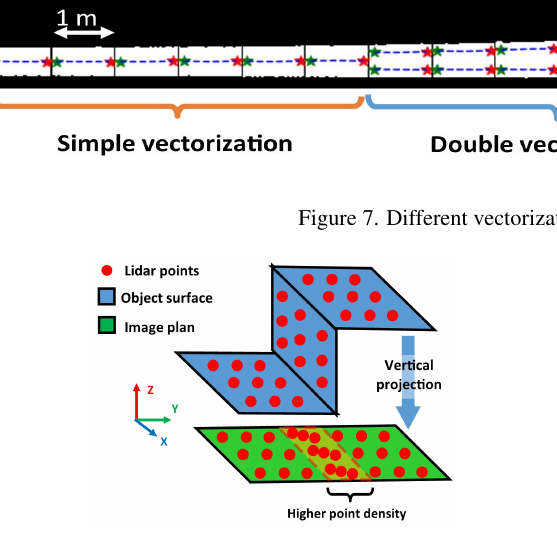
Figure 8. Vertical surfaces create high point density after a vertical projection.